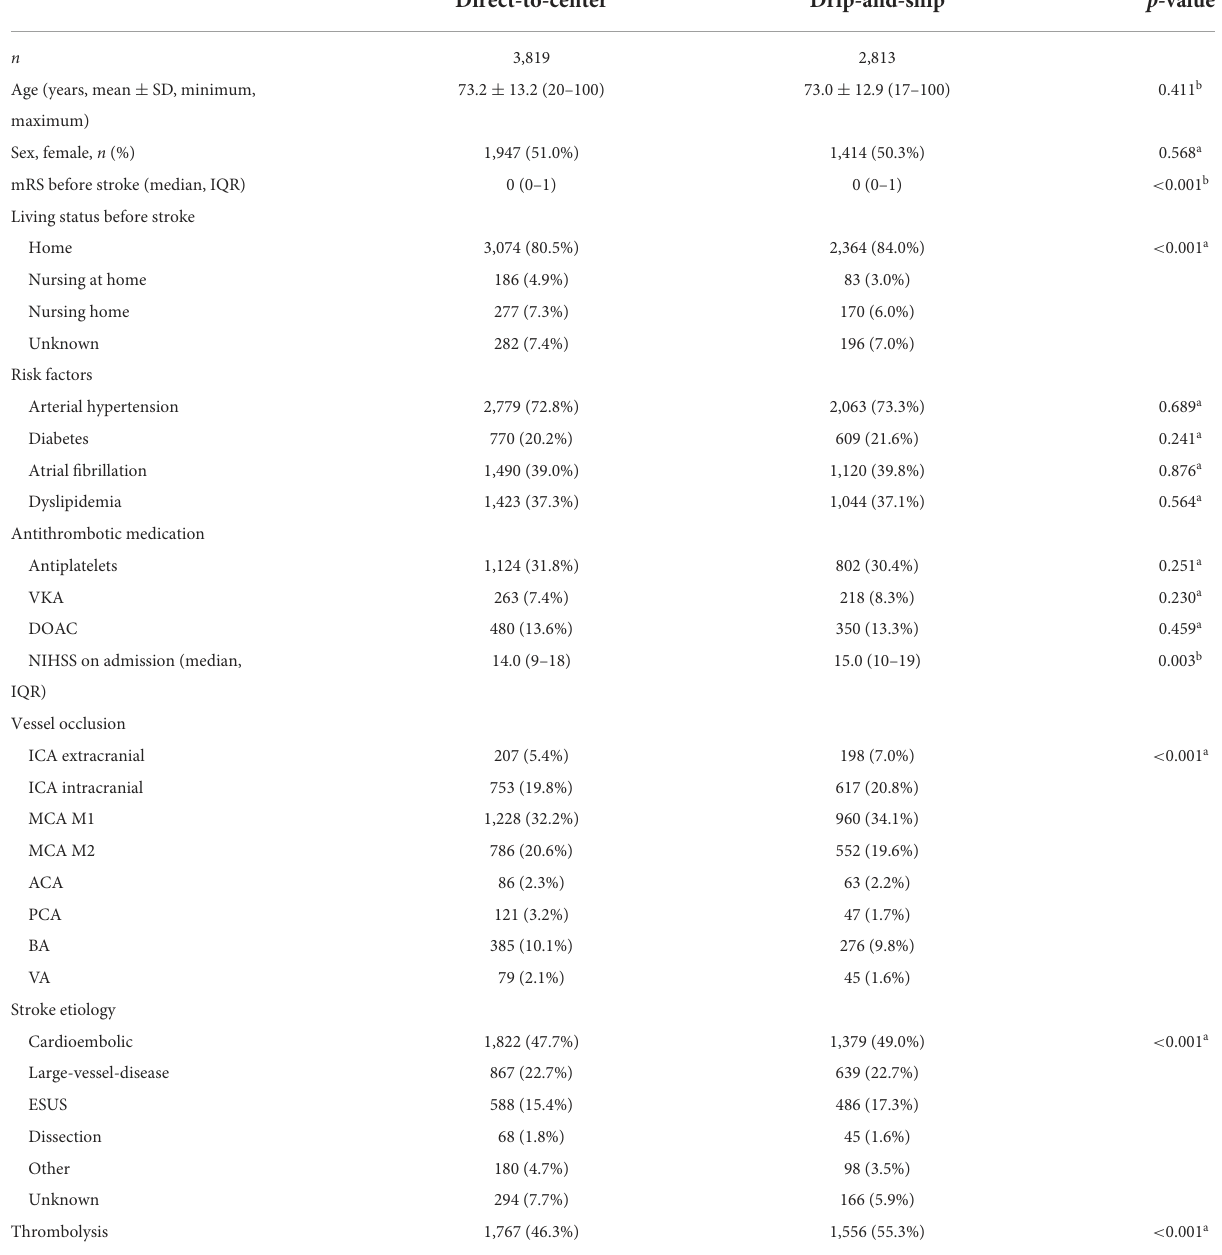
TABLE 1 Baseline, treatment and outcome characteristics for direct-to-center and drip-and-ship admission status, analyzed by χ 2 -test a for categorical data and Mann-Whitney- U -test b for continuous, non-Gaussian data. Direct-to-center Drip-and-ship p -value 3,819